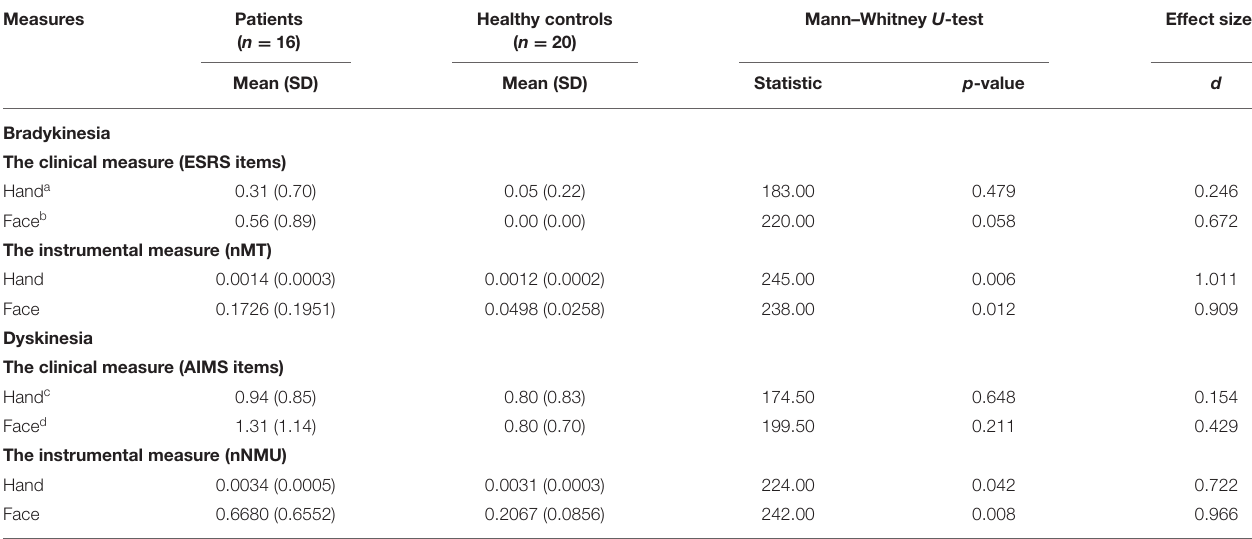
TABLE 3 | Group differences in bradykinesia and in dyskinesia detected using clinical measures and instrumental measures. Measures